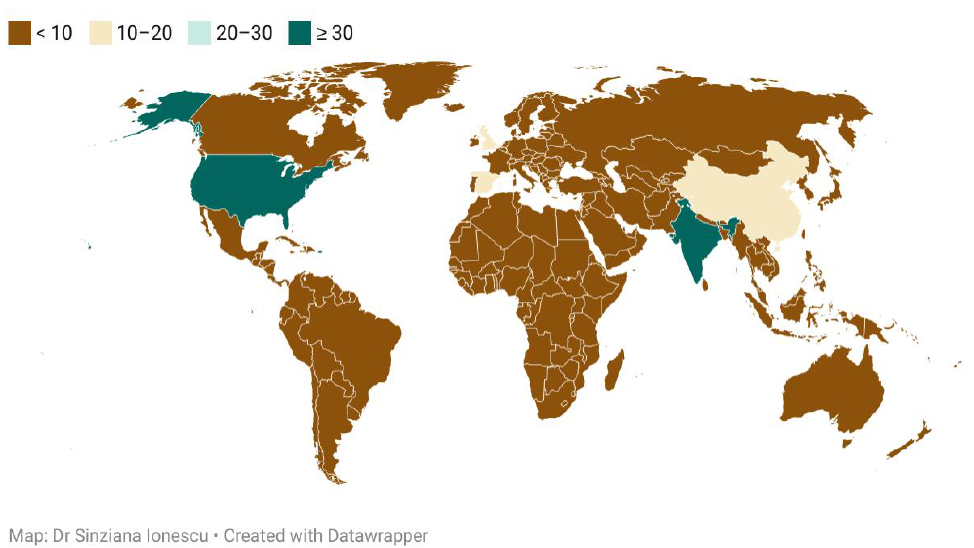
Figure 2. Choropleth map with consulted articles and their country of provenience.